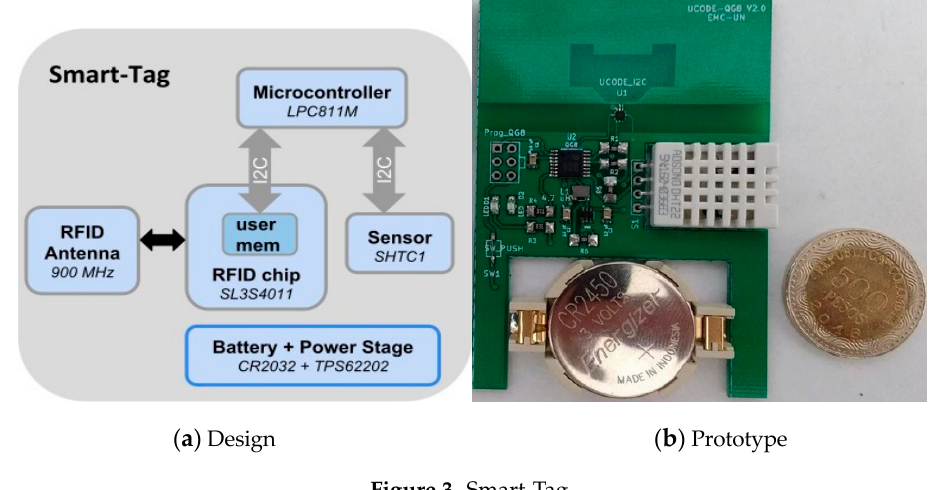
Figure 3. Smart-Tag.